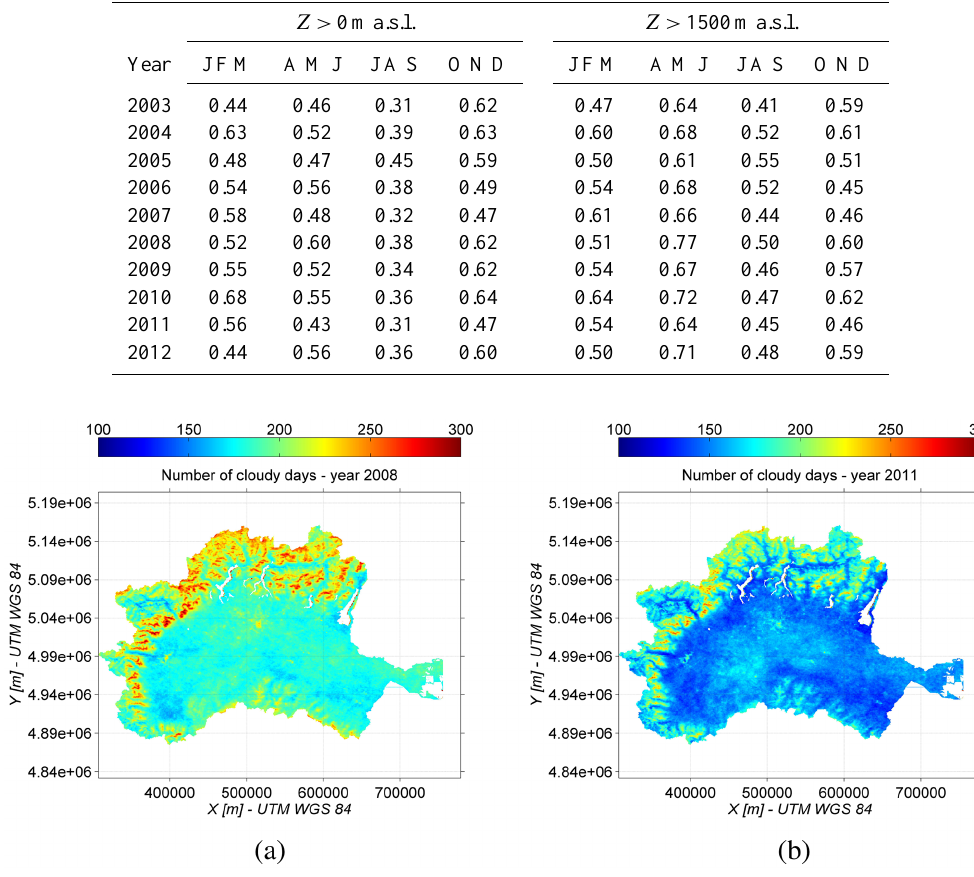
Figure 6. Cloud obstruction maps for years 2008 (a) and 2011 (b) . They represent the number of cloud observations per pixel from MOD10A1 SCA product (0–366 / 365 days).